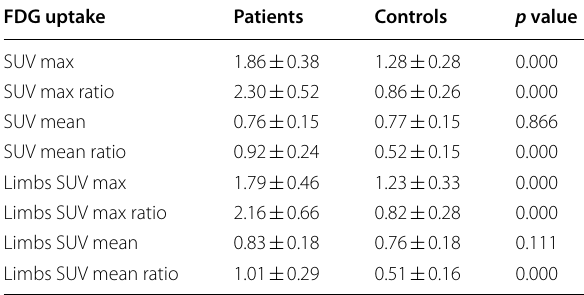
p value < 0.05 considered statistically significant